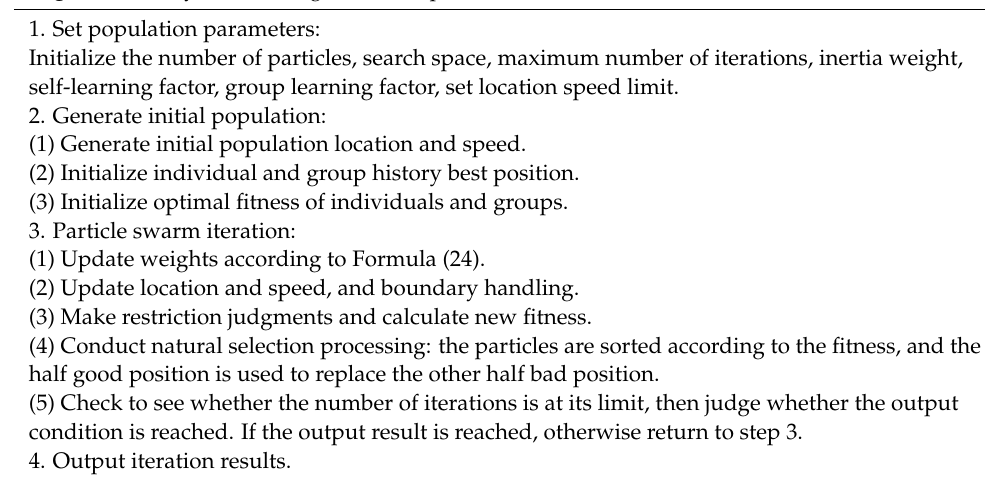
Algorithm 1 : Hybrid PSO algorithm for power